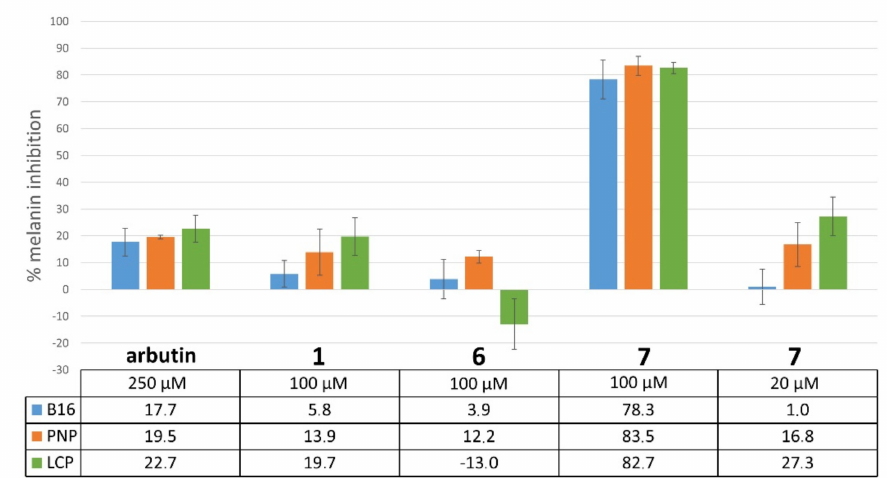
Figure 7. Inhibition of melanogenesis: B16F10 mouse melanoma cells (B16), PNP—mel (PNP) and LCP—mel (LCP) human melanoma cells, stimulated with 10 nM α MSH, where grown in the presence of 250 µ M arbutin or 100 µ M of either 1, 6 or 7 and 20 µ M of 7 , up to 48 h, as described in Materials and Methods. Percentages of melanin inhibition were calculated by comparing melanin content of α MSH—stimulated-treated cells to that of α MSH—stimulated-untreated cells (0% of inhibition). Data represent the mean results obtained by three experiments, each done in